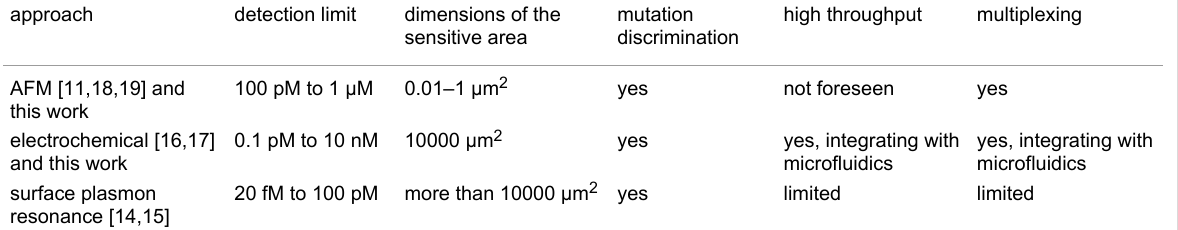
Table 2: Comparison among different surface-based label free approaches for the detection of